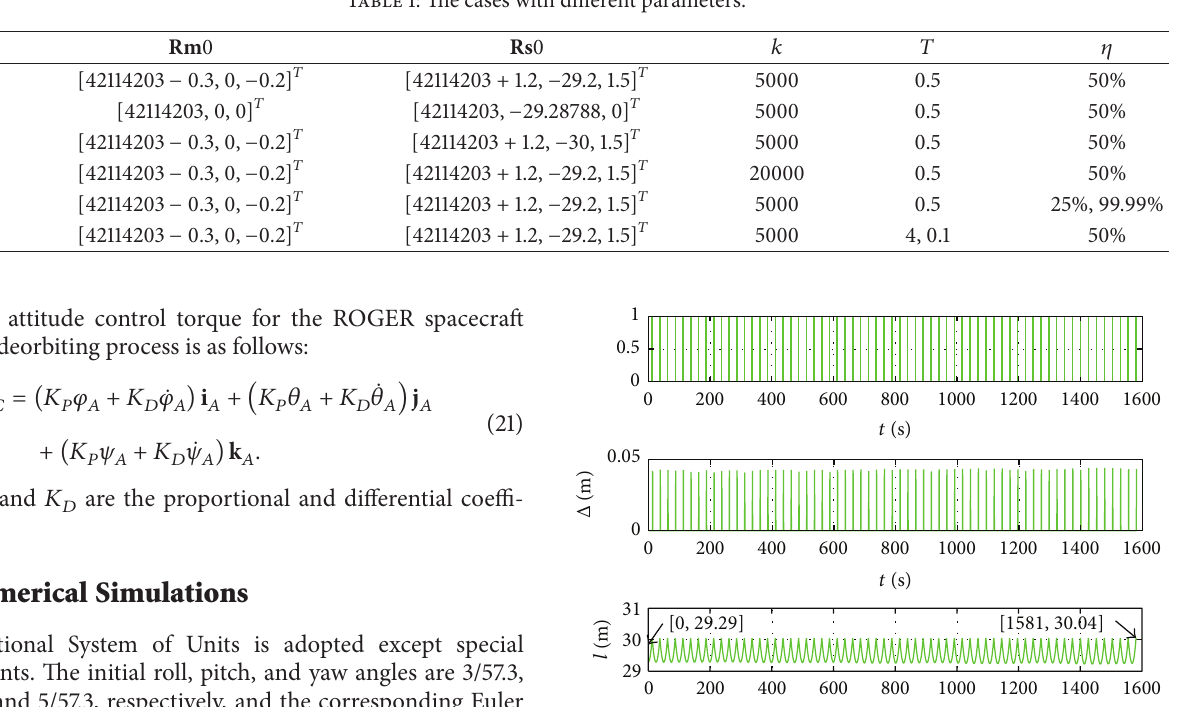
Table 1: The cases with different parameters.